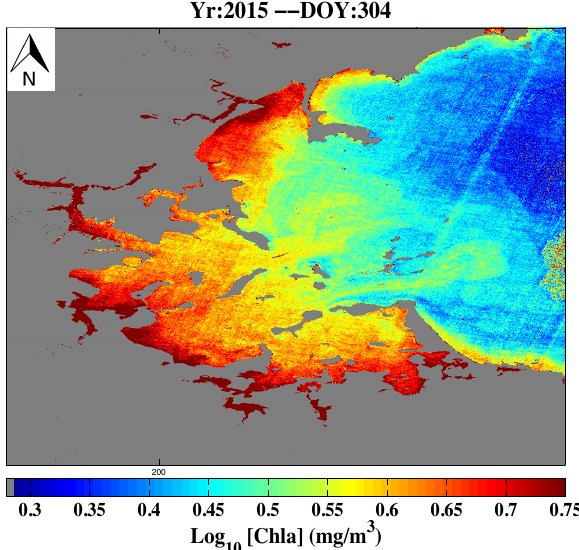
Figure 5. The OLI-derived Chl a products over Boston Harbour and Massachusetts Bay. While OLI provides clues on the relative productivity, it contains striping induced by instrument artifacts as well as per-pixel NIR-SWIR based aerosol